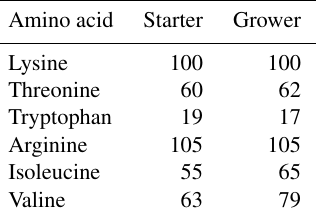
Table 5. Optimal dietary ratios for individual amino acids as related to lysine; results of a meta-analysis (Wecke and Liebert, 2013).